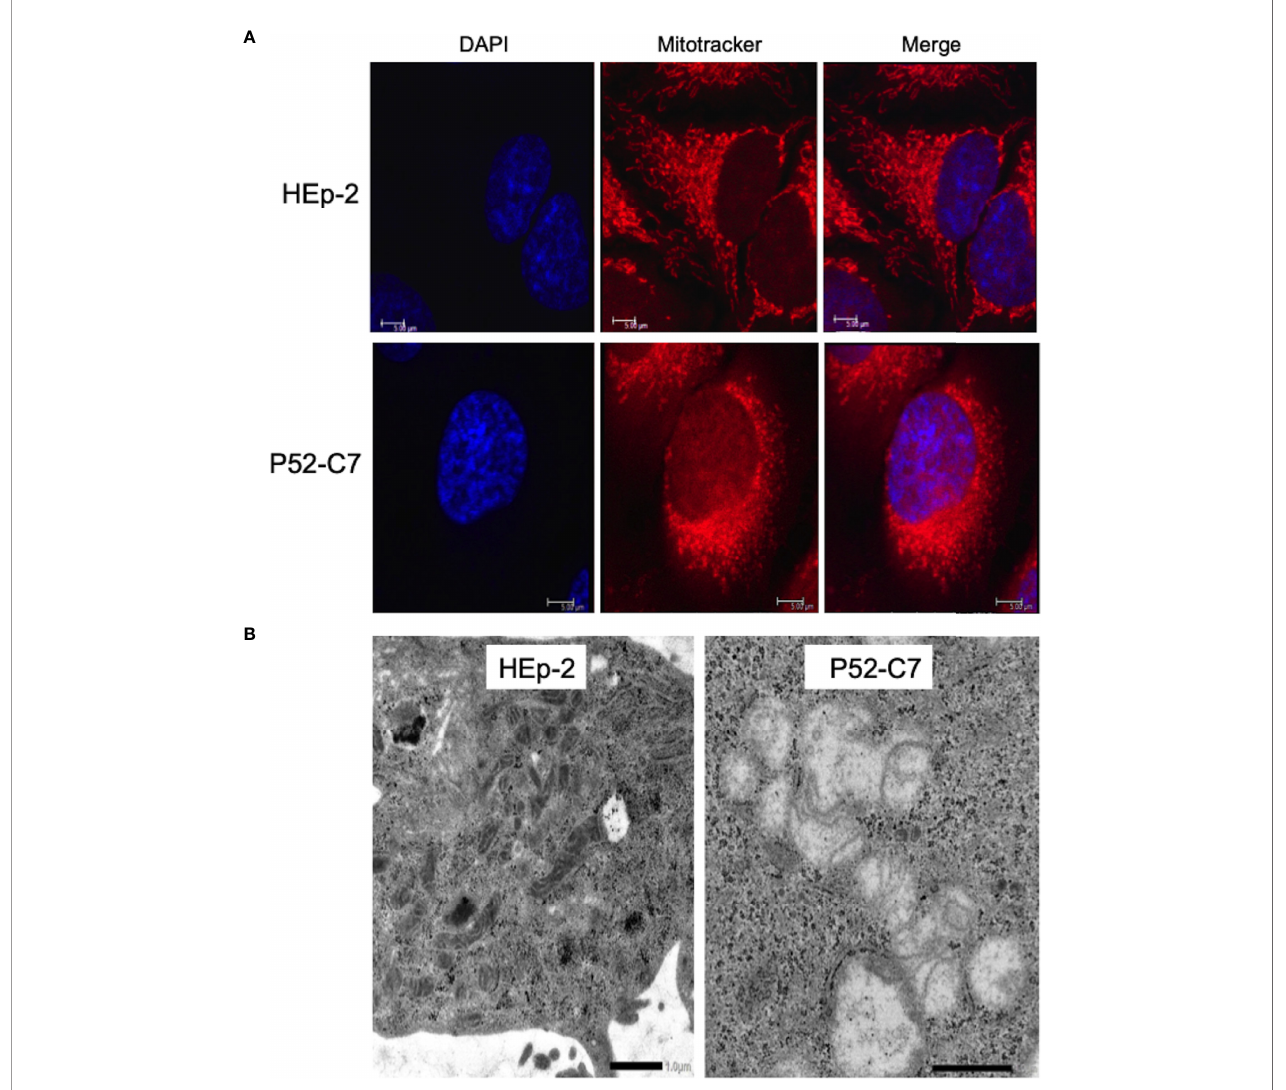
FIGURE 4 | Morphological features of mitochondria (Mt) in HEp-2 cells with or without ethidium bromide exposure. (A) Representative confocal laser microscopy images showing the localization and morphology of Mt in Mt d -HEp-2 (P52-C7) cells and parental HEp-2 cells stained using MitoTracker (see Methods ). Bars = 5 m m. (B) Representative transmission electron microscopy images showing the detailed morphology of Mt in Mt d -HEp-2 (P52-C7) cells and parental HEp-2 cells. Scale bars = 1 m